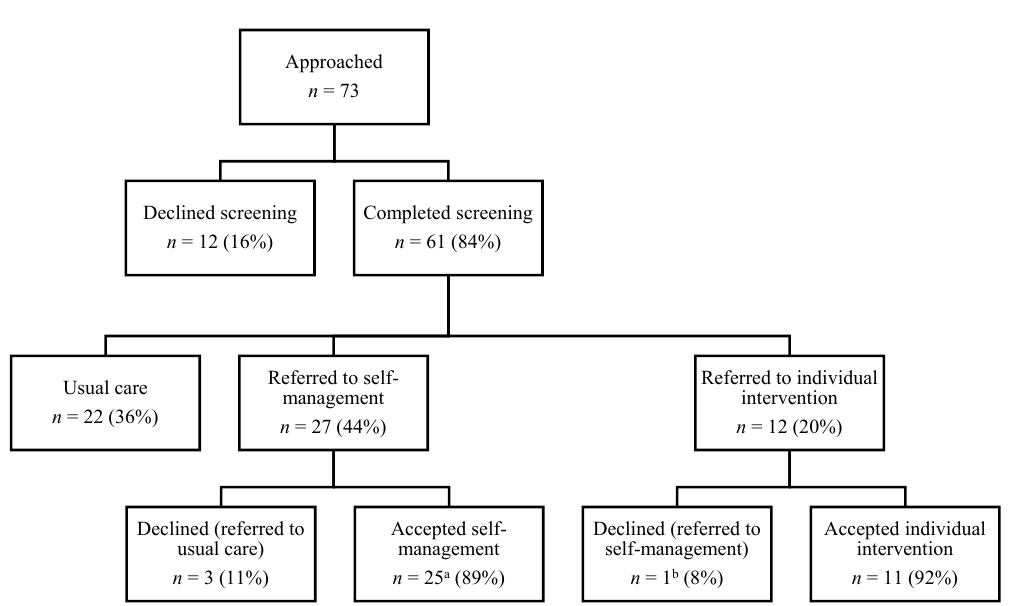
Figure 2. Stepped-care pathways of Fear-Less. a Includes one survivor who declined individual therapy and accepted self-management. b Referred to self-management instead. Table 1. Participants’ socio-demographic and treatment